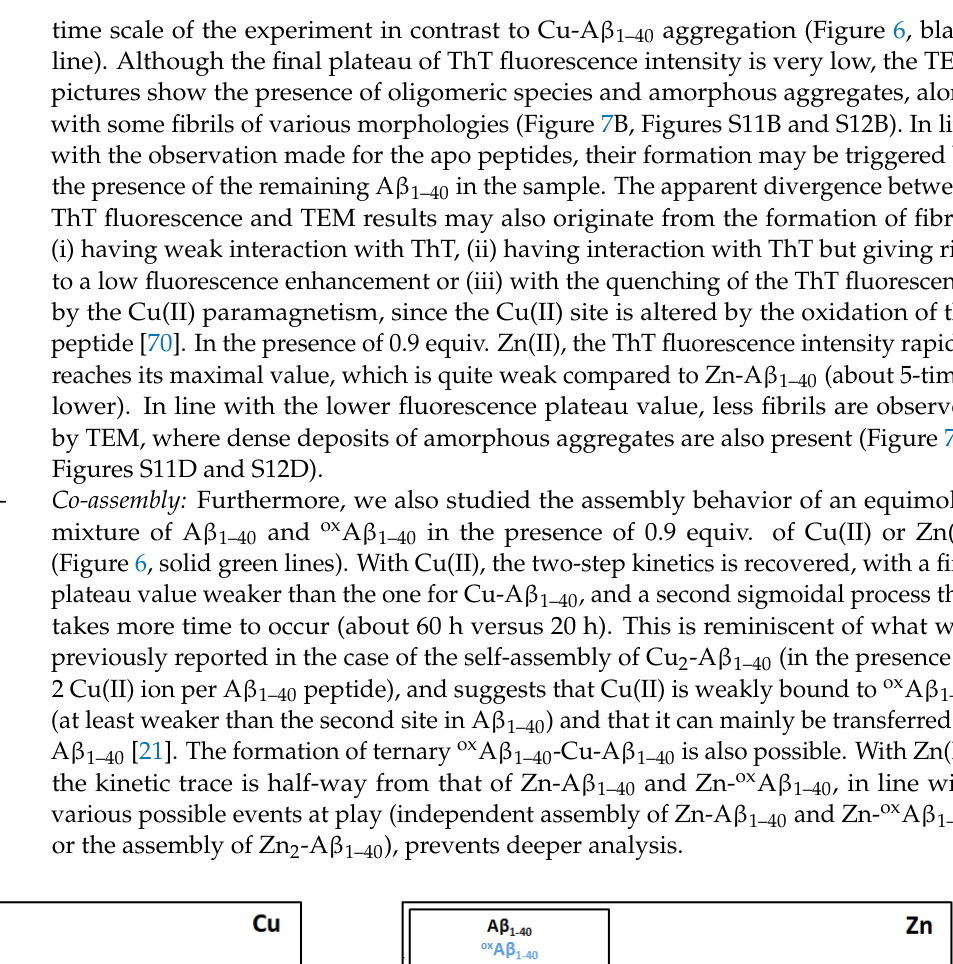
Figure 7. Selected TEM pictures of Cu(A β 1–40 ) and Cu( ox A β 1–40 ) at 20 µM (( A ) and ( B ), respectively) and of Zn(A β 1–40 ) and Zn( ox A β 1–40 ) at 20 µM (( C ) and ( D ), respectively) taken at the end of the ThT fluorescence experiment N°1. Hepes buffer 50 mM, [NaCl] = 65 mM, pH 7.4. Two shots are given to better illustrate the heterogeneity of the assemblies formed.